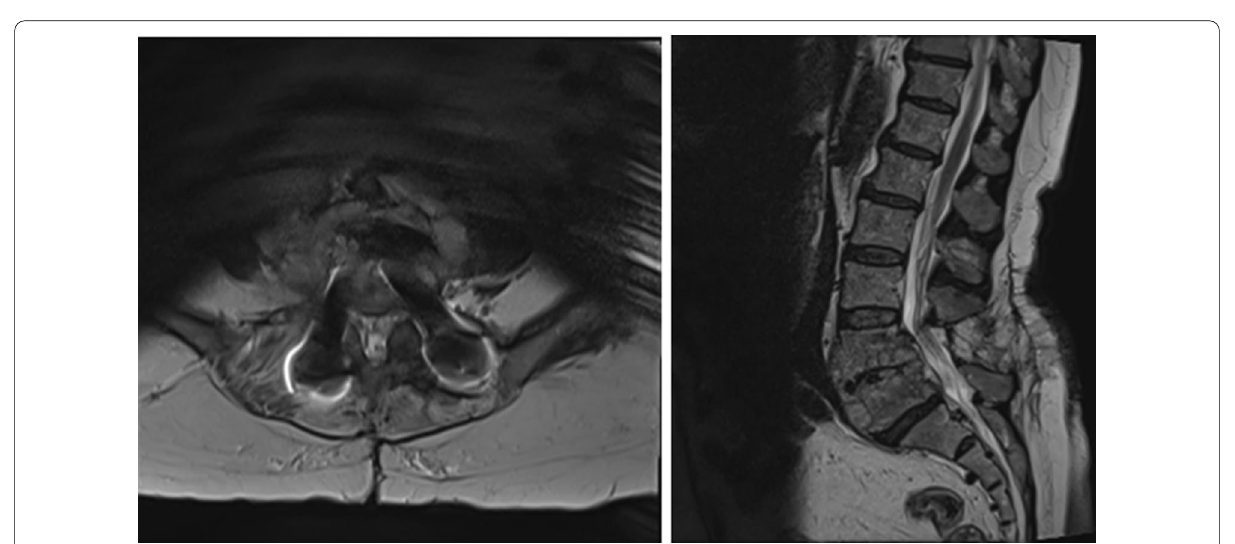
Fig. 3 Preoperative lumbo-sacral spinal MRI—axial and sagittal